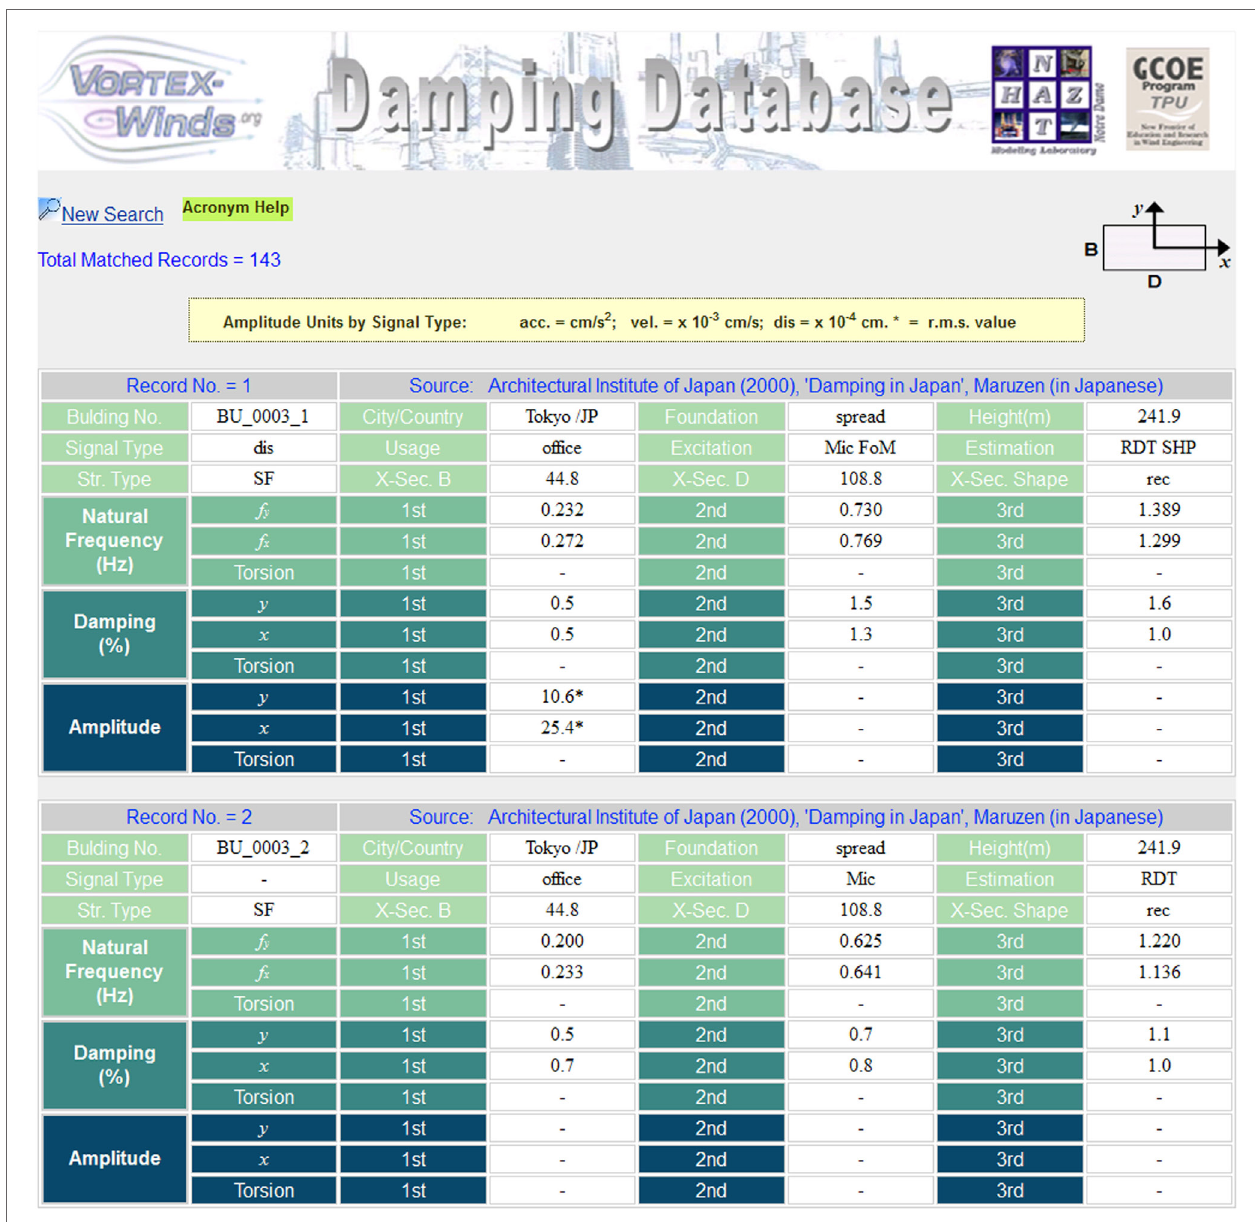
FigUre 10 | Damping Database: database-query (a) and result (B)